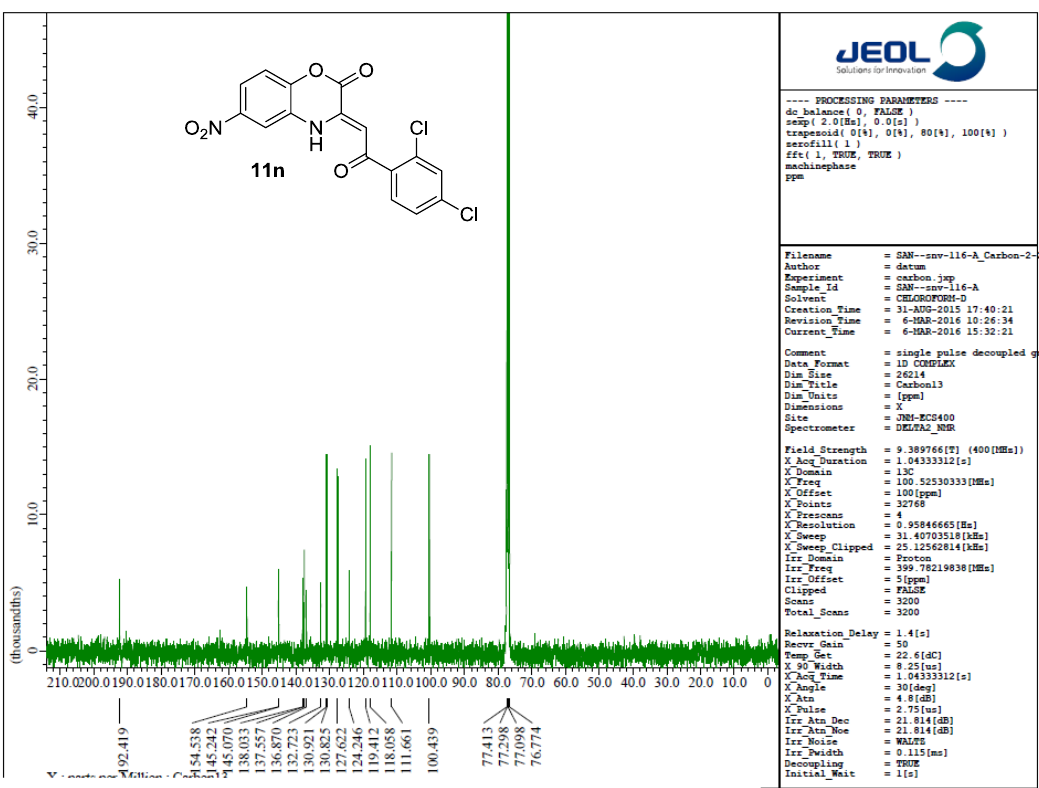
Figure 28. 13 C NMR Spectra of Compound